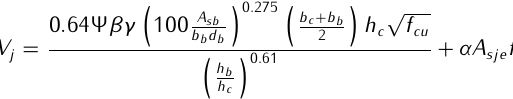
Figure 15. Influence of beam longitudinal reinforcement ratio.